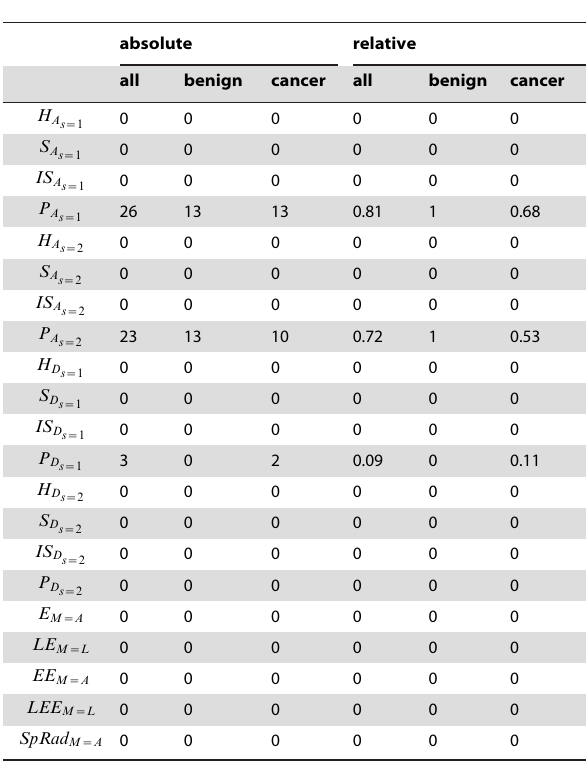
Table 10. ndV-values for the structural biomarkers (eigenvalue and entropy-based measures) for prostate cancer networks and the corresponding subgroups (benign/cancer) for